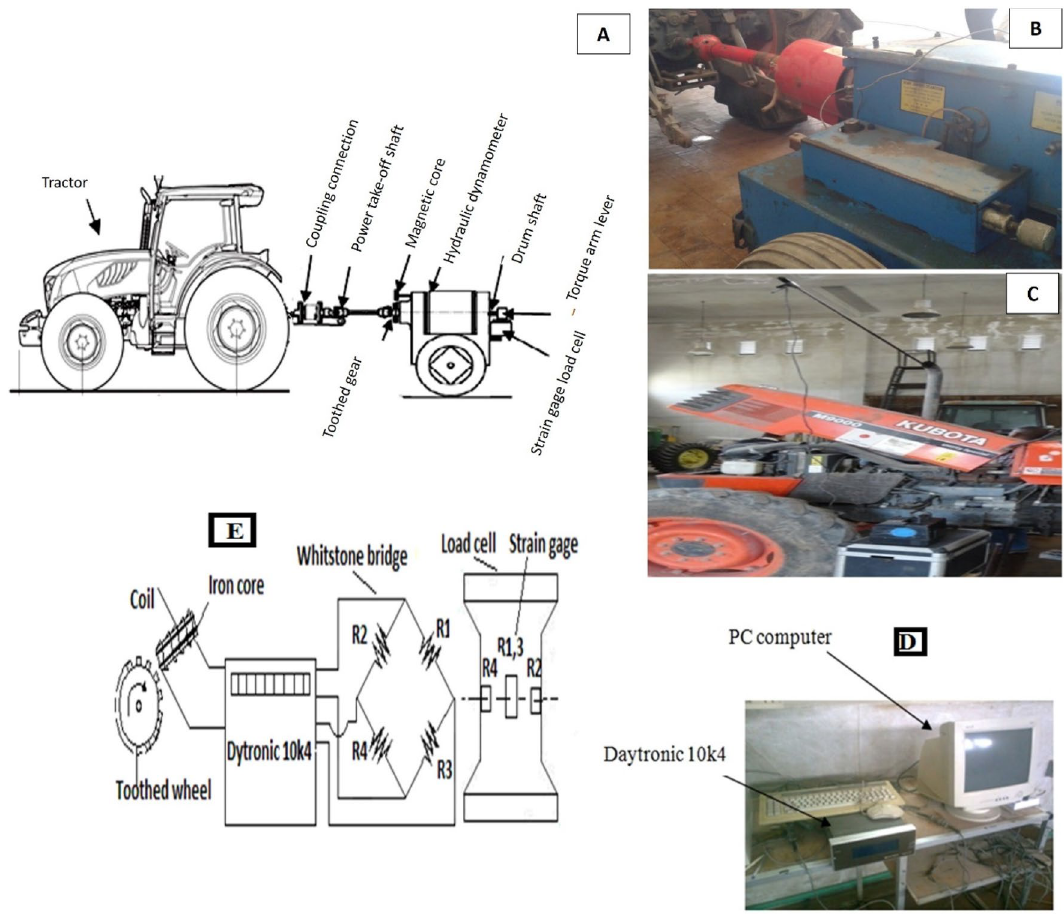
Figure 1. Tractor test equipment ( A , B ), connecting gas analyzer with the tractor ( C ), ( D-E ) A data acquisition system to save the measurements on the 10 min to consume fuel residue after the fuel type was changed before each test. Five loading stages of 0, 25, 50, 75 and 100% were selected for every test. The engine started up at no loading stage with maximum speed; dynamometer sensors and Daytronic (model 10k4, https:// www. daytr onic. com/ resou rces/ softw are- manua ls/) was used to record measured data by the pick-up frequency and torque sensor according to 28 , which engaged to the hydraulic dynamometer. The torque sensor comprises of a full whinstone bridge of strain gage for record the torque exerted on PTO shaft during loading test. The pick-up frequency sensor was used to recording the rpm of the PTO shaft, which comprises of a toothed wheel and coil around an iron core, the magnetic field of the magnetized cause is detected when the toothed wheel rotates and displayed as rpm. A data acquisition system was used to save the measurements on the computer, as shown in Fig. 1d,e, the load on the PTO shaft was increased by using a hydraulic dynamometer until a max load of 100% was reached, which led to a minimum speed. The dynamometer was equipped with torque and speed sensors to measure the torque and speed of the PTO shaft at each loading stage. The performance indicators of the turbocharged diesel engine were calculated using the measured torque, speed of PTO shaft, fuel consumption, and time for each test. The quality of gas emissions was measured with a portable gas analyzer (NOVA 7460), which consists of electrochemical sensors and infrared